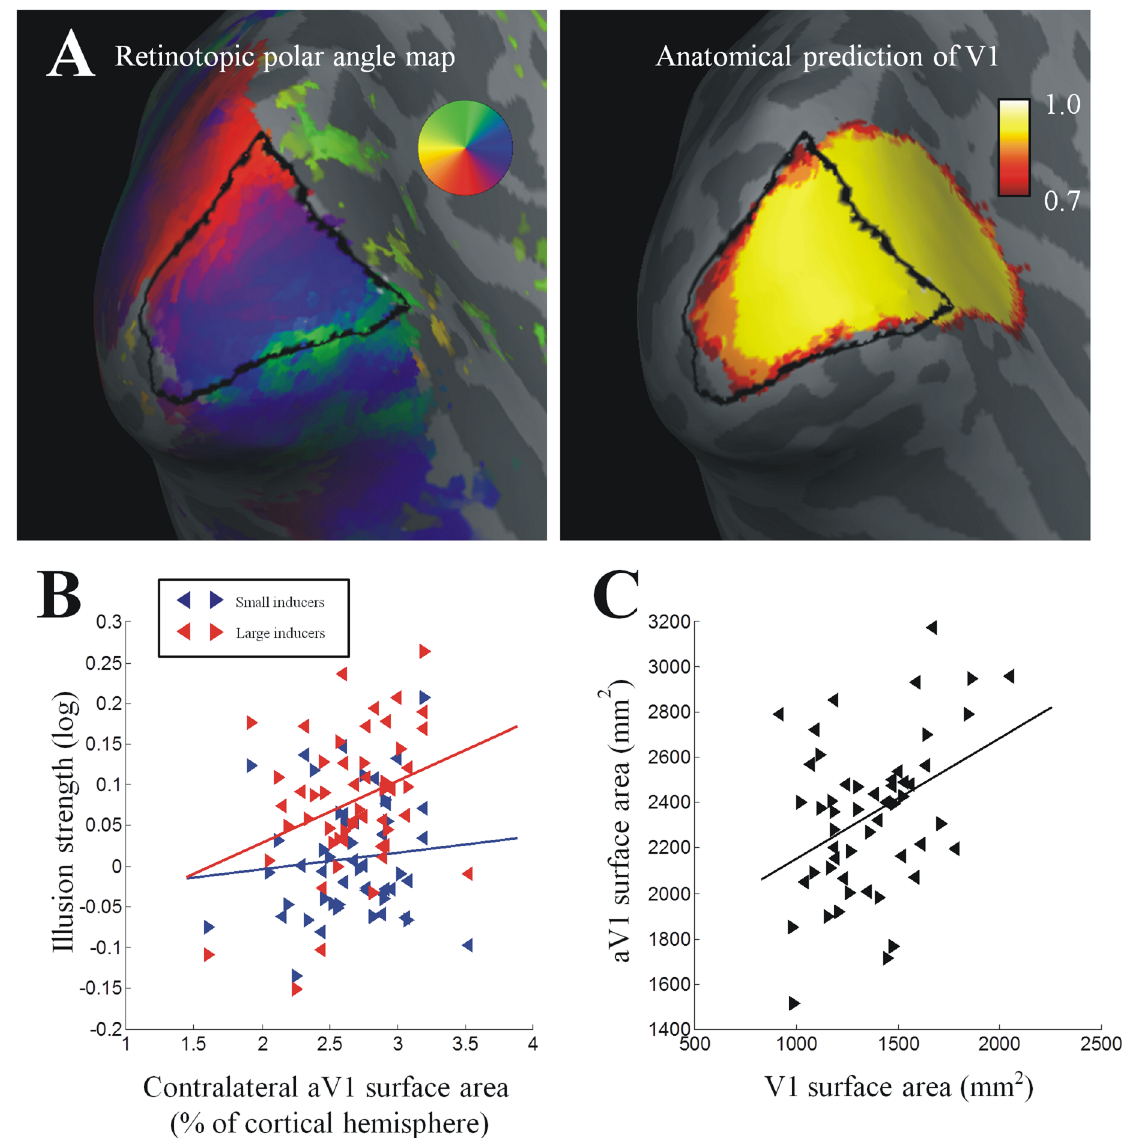
Figure 5. Anatomical definition of V1. A. Left: Retinotopic polar angle maps from a typical participant shown on an inflated reconstruction of the grey-white matter boundary. Shades of gray indicate gyri and sulci. The colour indicate polar angle coordinates of visual field positions mapped onto the cortex. Right: The probability (p . 0.7) that occipital vertices fall within aV1 as determined by anatomical criteria [19]. The overlaid black line denotes the boundaries of V1 delineated functionally through retinotopic mapping. B. Individual illusion strengths plotted against the surface area of contralateral aV1 (expressed as percentage of the cortical hemisphere). Blue: small inducers. Red: large inducers. C. Anatomical aV1 surface areas plotted against retinotopic V1 surface areas. In both plots, left and right pointing triangles denote measurements from left and right visual hemifields/cortical hemispheres in individual participants, respectively. Solid lines are linear regression fits.